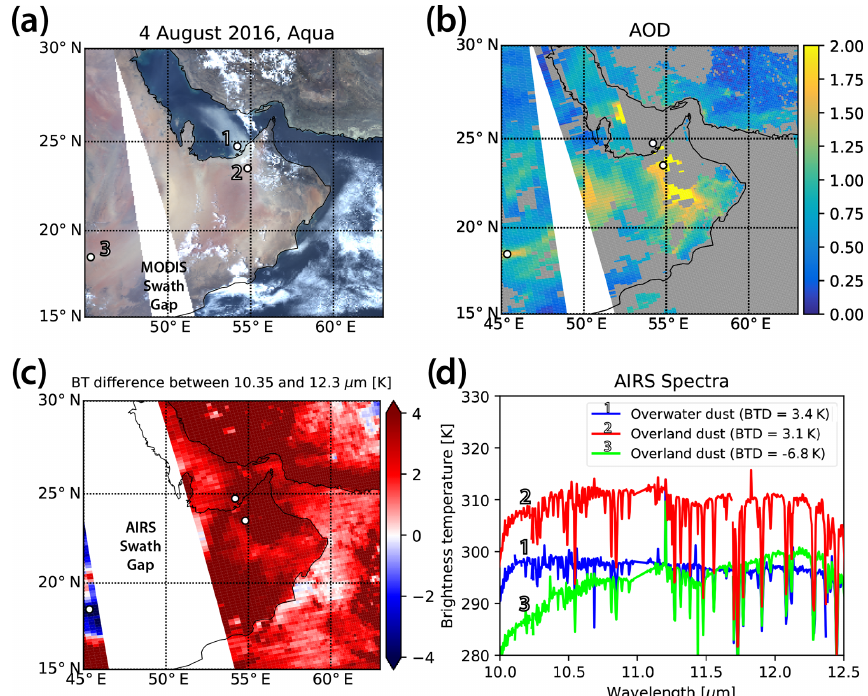
Figure 5. NASA Aqua satellite measurements for the 4 August 2016 (09:15UTC) case study, showing (a) MODIS true color imagery, with sample locations for the missed dust plume overwater (1) and overland (2), and a southwestern portion of the extensive and well-detected inland plume (3), (b) corresponding MODIS AOD retrieval, (c) AIRS-derived SWBTD (10.35–12.3µm), and (d) resolved AIRS spectra across the split-window region for the three sample locations noted in (a) . The specific AIRS SWBTD value at each location is given in the